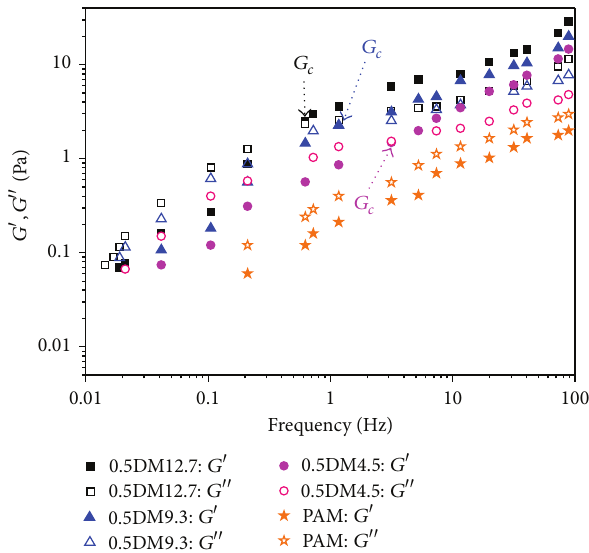
Figure 9: Storage ( 𝐺 󸀠 ) and loss ( 𝐺 󸀠󸀠 ) modulus as a function of frequency for copolymers 0.5DM12.7, 0.5DM9.3, and 0.5DM4.5 and for PAM ( 𝑐 𝑝 = 1.0g dL −1 , 𝑇 = 25 ∘ C).